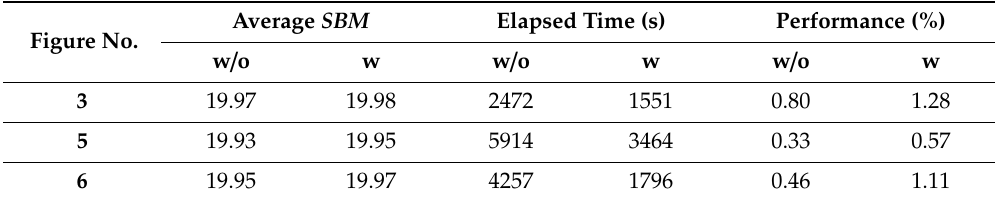
Table 1. Average successful bandwidth management ( SBM ) results of the scenarios without (w / o) and with (w) the cooperation of fog